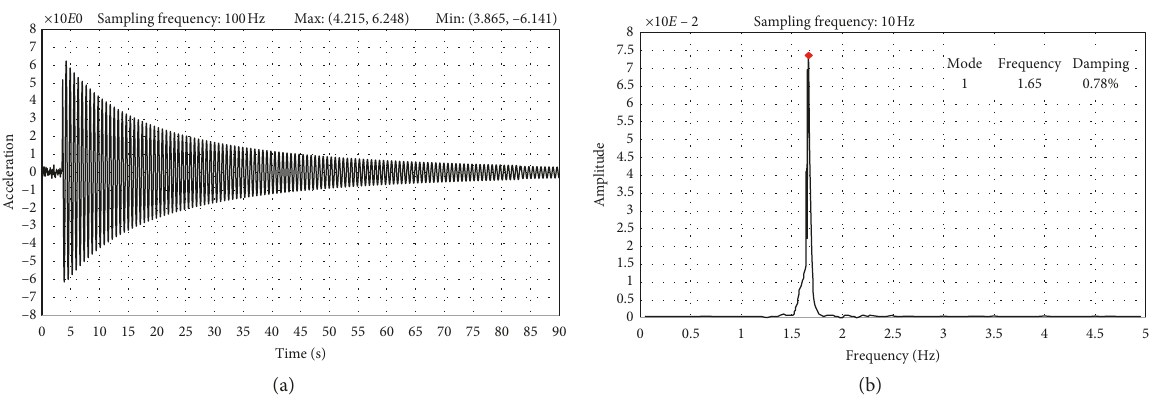
Figure 17: Monitoring results with the particle damper (9 alumina balls in container). (a) Acceleration-time history curve of the frame. (b) Identified frequency and damping